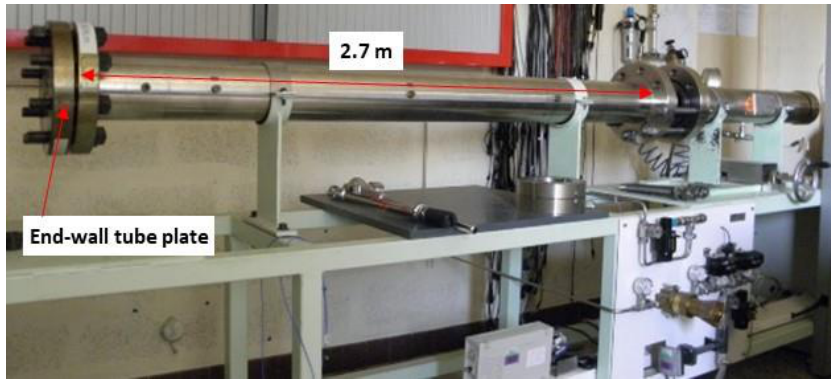
Figure 23. Photograph of the shock-wave tube used at CEA-Gramat.